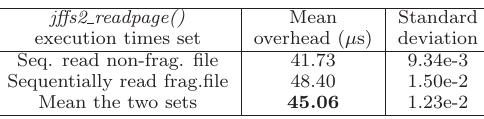
Table 2: jffs2 readpage overhead results.